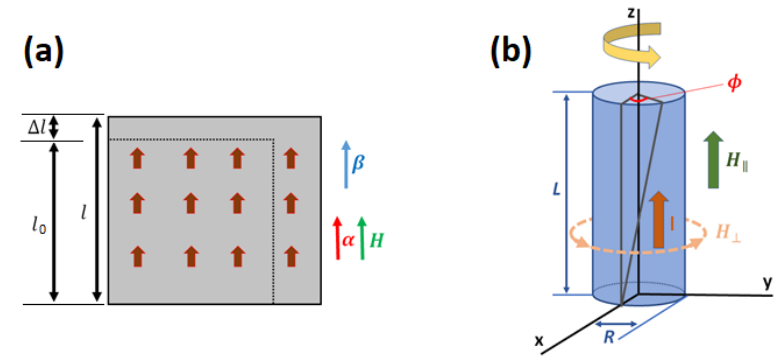
Figure 1. Sketch of the ( a ) Joule effect and ( b ) Wiedemann